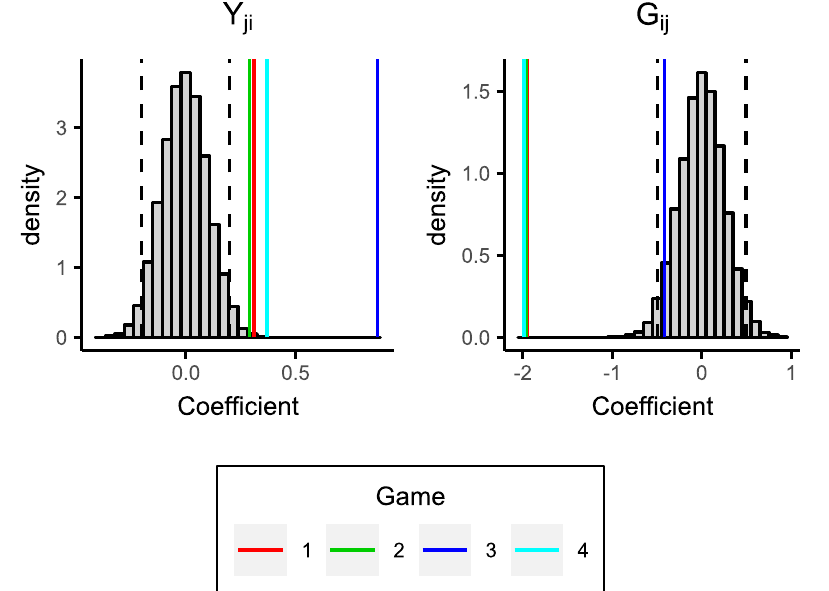
Figure 7. Coefficients for the additive effects models. Game coefficients are the vertical coloured lines. The histograms show the model coefficients from synthetic giving-at-random null games. 95% of values lie between the black dashed lines.